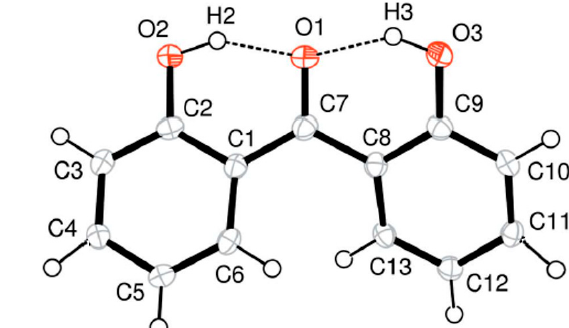
22 of 29 Figure 8. Example of calculation of the enthalpy of formation, ∆ (cid:2916) (cid:1834) mo (g, 298.15 K), of 2 ‐ hydroxy ‐ 4 ‐ methoxy ‐ benzophenone using the “centrepiece” approach with the numerical values from Table 9.